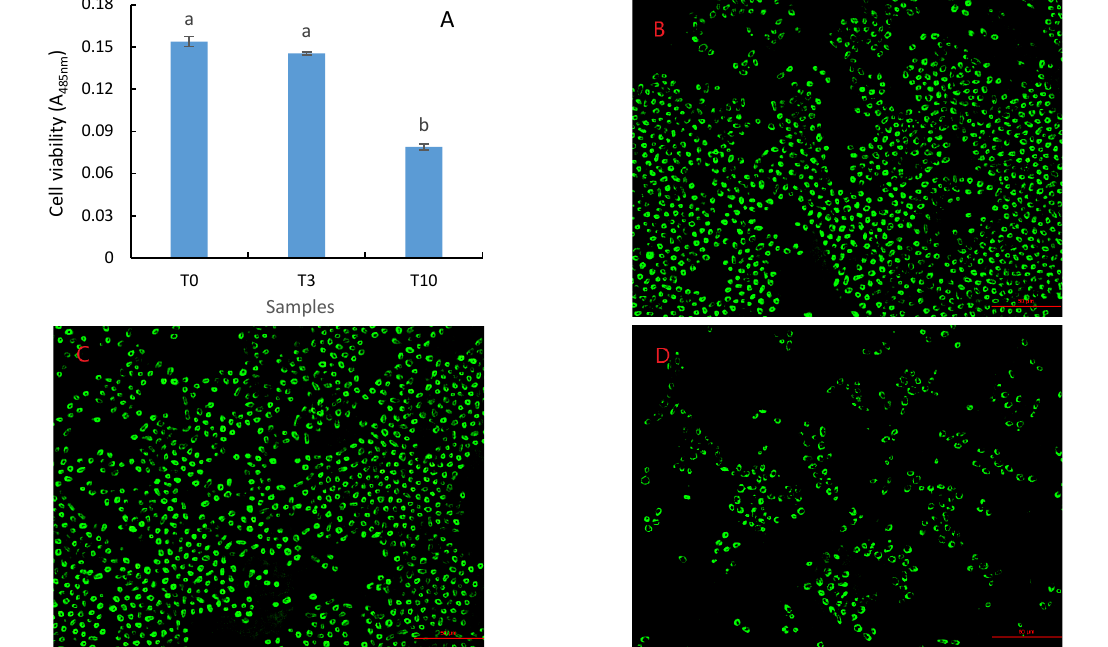
Figure 3. Effects of D. officinale on the cell viability of S. cerevisiae . T0, T3, and T10 were the samples with 0, 30, and 100 g/L of D. officinale , respectively. Different letters indicate significant differences at p < 0.05. ( A ): value of cell viability; ( B ): T0; ( C ): T3; ( D ): T10.